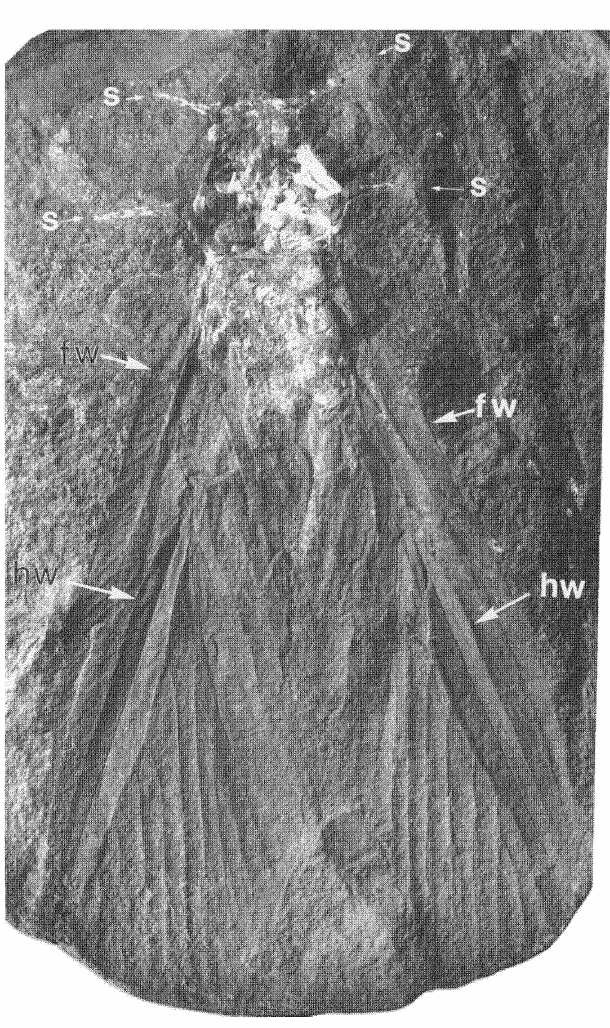
Fig. 9. Gerarus danielsi, photograph of the holotype, USNM 35574. Length of fore wing 42 mm, as preserved, fw fore wing; hw hind wing;